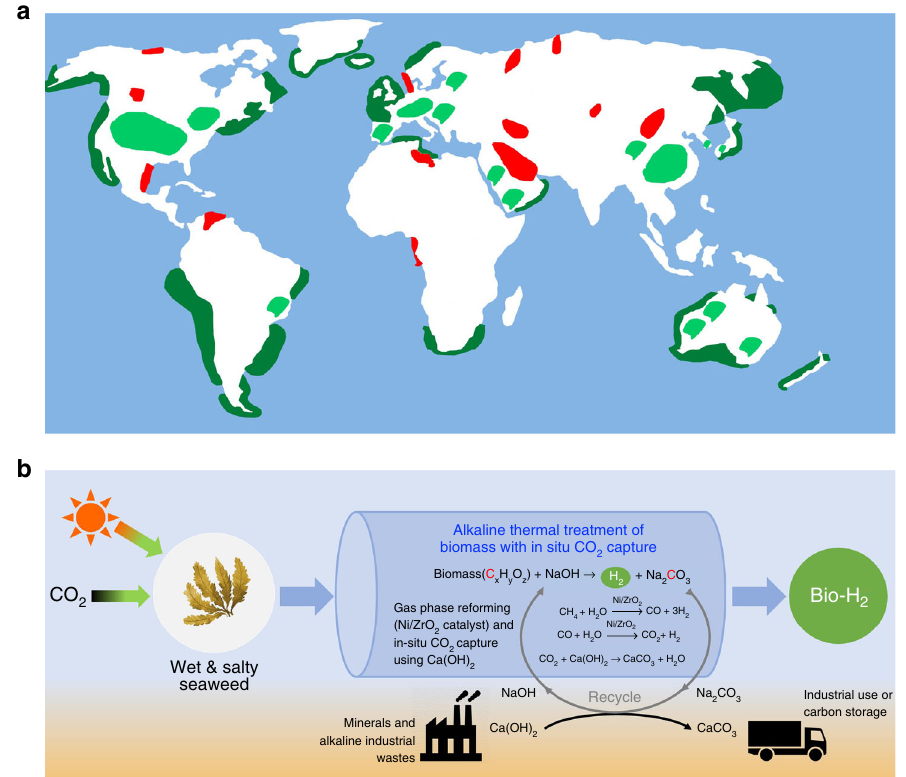
Fig. 1 Distributed unconventional biomass resources and a reaction pathway to bio-hydrogen with carbon capture. a Global distribution of seaweed (green) and algae (light green) compared to major oil reserves (red). b Alkaline thermal treatment (ATT) of seaweed innovatively produces high purity bio-H 2 from wet and salty biomass feedstock with a carbon capture and storage potential. Seaweed absorbs CO 2 from atmosphere and stores the solar energy through photosynthesis without needing fresh water. The catalytic ATT involves the conversion of seaweeds in the presence of hydroxide and gas phase reforming catalyst. The overall reaction leads to bio-H 2 as the carbon-free energy carrier, while carbon in biomass is stored as solid